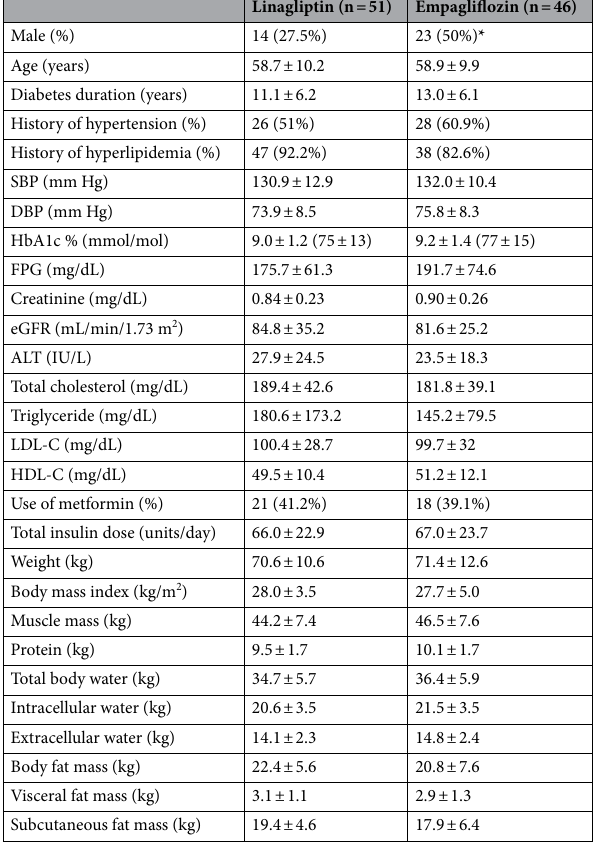
Table 1. Baseline characteristics of the trial participants. The data presented are n (%) or mean ± SD. SBP systolic blood pressure, DBP diastolic blood pressure, HbA1c glycated hemoglobin, FPG fasting plasma glucose, eGFR estimated glomerular filtration rate, ALT alanine aminotransferase, LDL-C low density lipoprotein, HDL-C High density lipoprotein. * p value < 0.05.